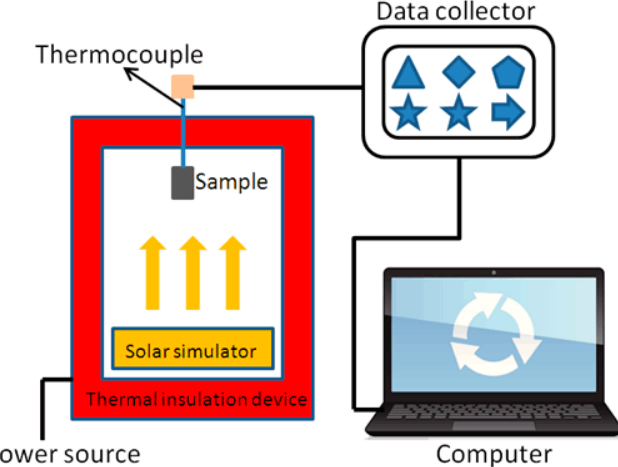
Figure 3. The apparatus for evaluating the light-thermal conversion performance [28].